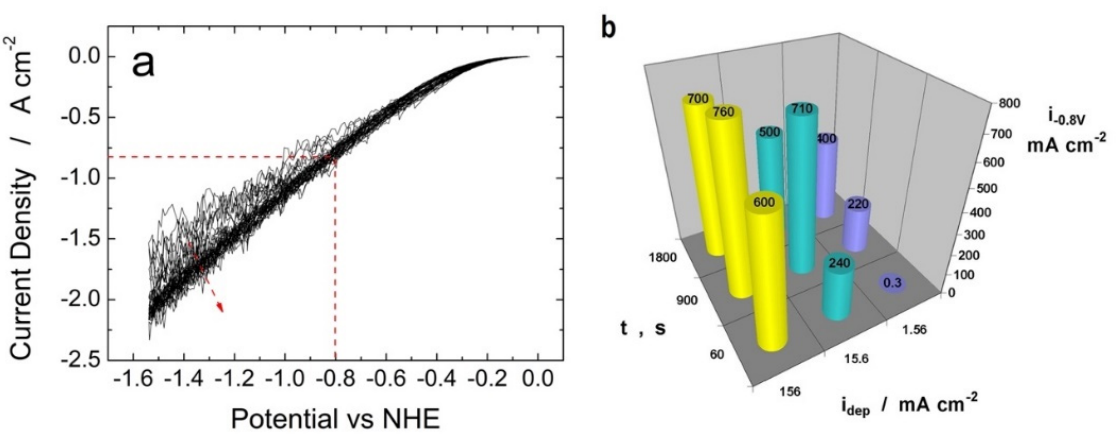
Figure 1. ( a ) The CV curves of the Pd–Co alloy obtained from dilute solution at − 156 mA cm − 2 for 900 s. ( b ) Current density values for HER (mAcm − 2 ) at − 0.8 V/NHE obtained from CV for the Pd–Co alloys obtained from a dilute solution (about 17% in Pd) at different deposition current density. Table 5. The current density values for HER (mAcm − 2 ) at − 0.8 V/NHE obtained from CV carried out in 2 M H 2 SO 4 for samples of Pd and Co electrodeposited on carbon paper under different conditions.